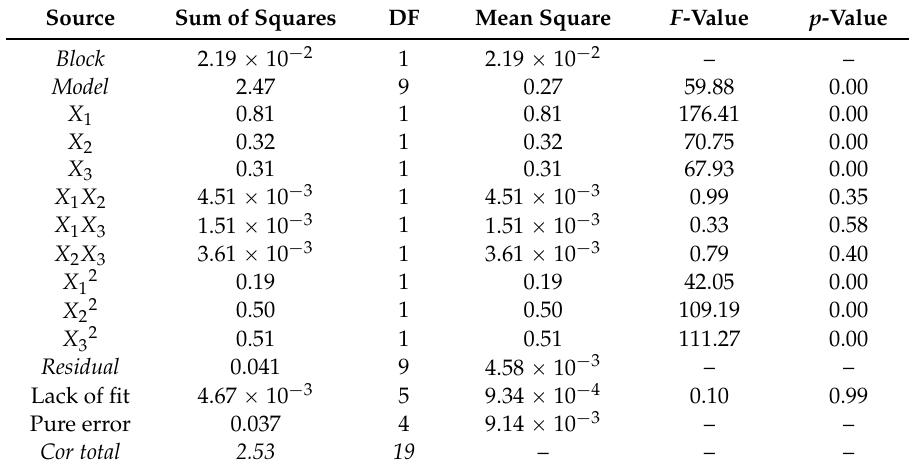
Table 2. ANOVA of response surface quadratic model for extraction yield of polysaccharides from T. chinesis var. mairei .